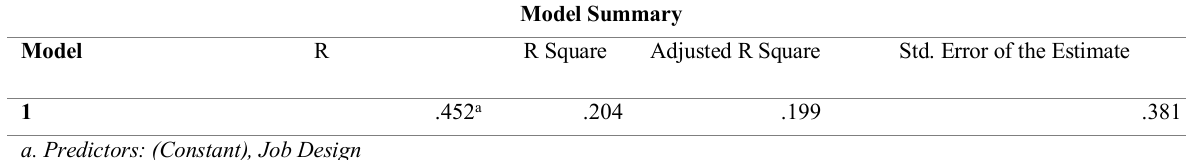
Table 3 (a): Regression Model Summary for Job Design and Employee Engagement